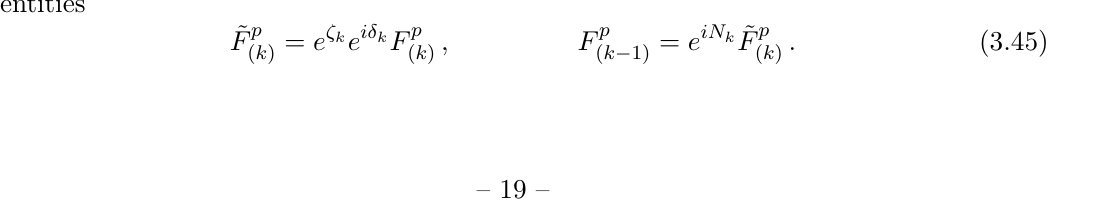
Figure 2. Flowchart illustrating the algorithm for constructing the sl(2)-approximation. This figure focuses on the construction of the sl (2) -split Deligne splittings ˜ I p,q rotation that has to be applied on the limiting filtration F p downward arrow corresponds to an iteration of the sl (2) -splitting algorithm for the Deligne splitting , where δ are determined by (3.40) and I p,q k , ζ k ( k )